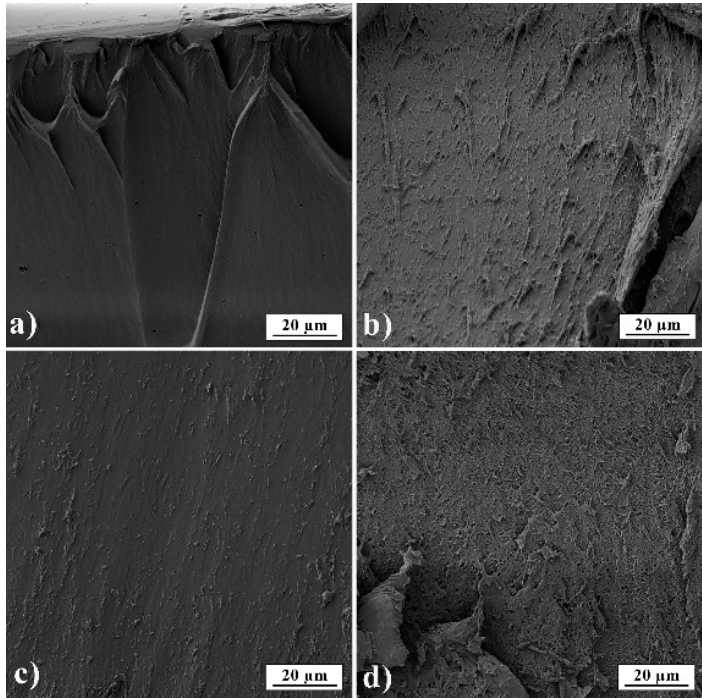
Figure 6. SEM micrographs of films’ fractured surfaces ( a ) GA; ( b ) GB; ( c ) GAP; ( d ) GBP.